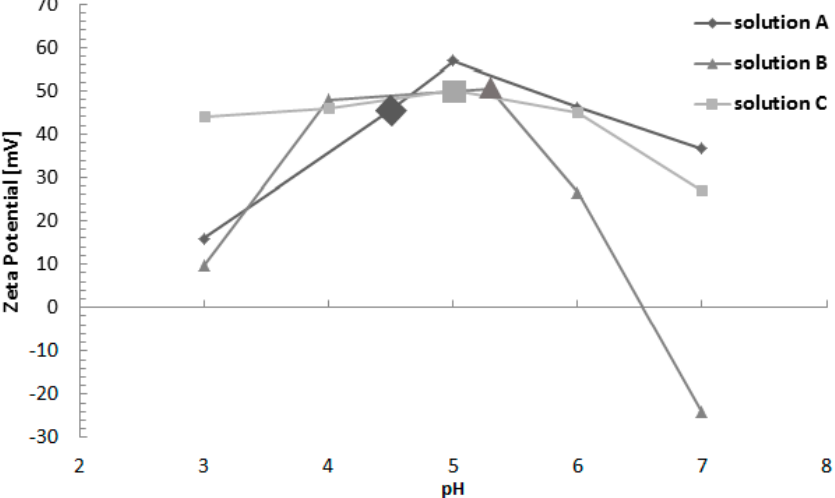
Figure 4. Zeta-potential vs. pH for Re:IF-MoS 2 nanoparticles. The (positive) ZP of the genuine solutions used for EPD of the HA + IF film are marked by enlarged symbols.